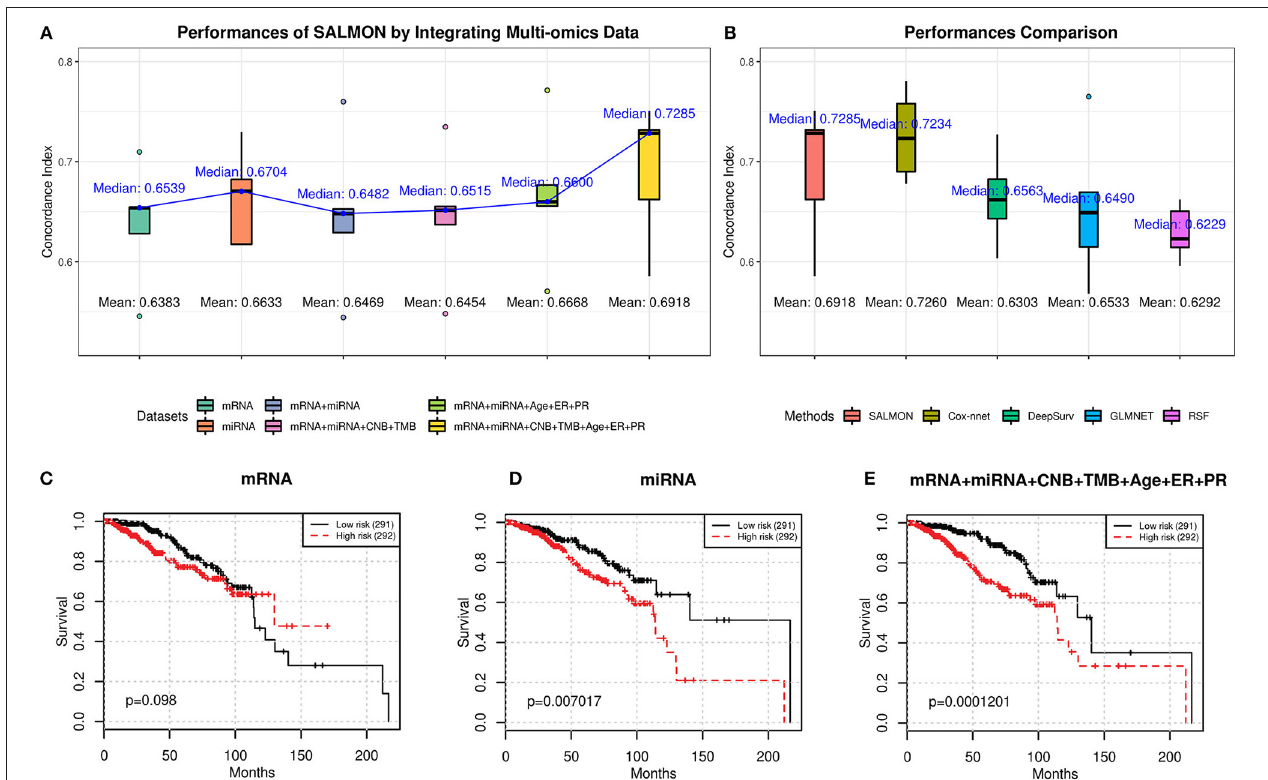
FIGURE 2 | (A) Performances of SALMON with multi-omics data integrated in terms of concordance index. (B) Performance comparison between SALMON and the modified Cox-nnet, DeepSurv, GLMNET, and RSF in terms of concordance index with all omics data used for learning. (C–E) Kaplan-Meier plot of survival prognosis. Hazard ratios were derived from all five testing sets. Log-rank test was used to find the corresponding p-value with low risk and high risk groups dichotomized by the median hazard ratio. Omics data used for training and testing: (C) mRNA-seq data (mRNA); (D) miRNA-seq data (miRNA); (E) integration of mRNA, miRNA, CNB, TMB, and demographical & clinical (diagnosis age, ER status, PR status) data. All other combinations of multi-omics results are in Figure S1 .